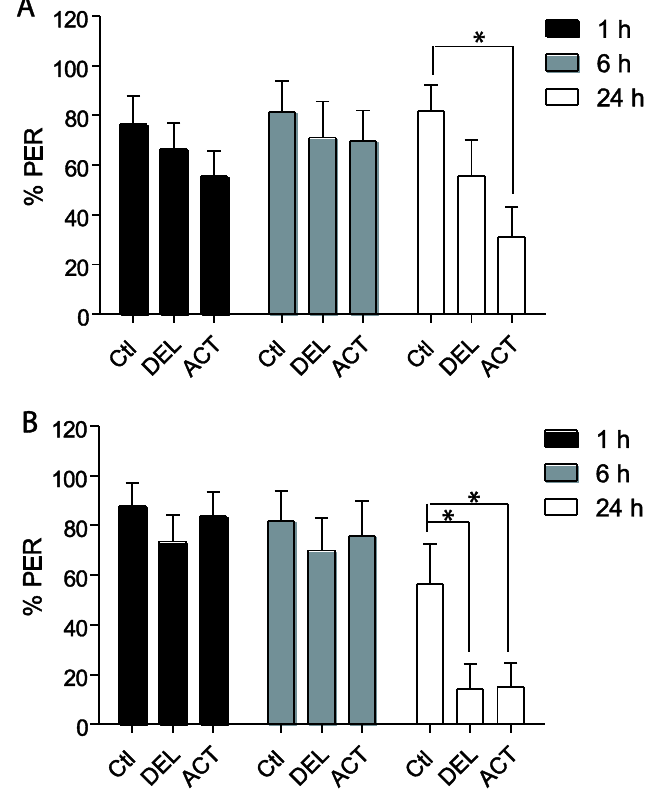
Figure 5. Retrieval responsiveness of honey bees when drugs are applied during learning sessions. ( A , B ) bees treated with 10 ng/bee or 100 ng/bee of ACT or DEL, respectively. Data are expressed as the percentage of PER performance to antennal stimulation with 40% sucrose. Significant results are indicated by * p < 0.05. Each group represents n = 90 bees. Bars represent standard errors. Acetamiprid (ACT), deltamethrin (DEL), and control groups